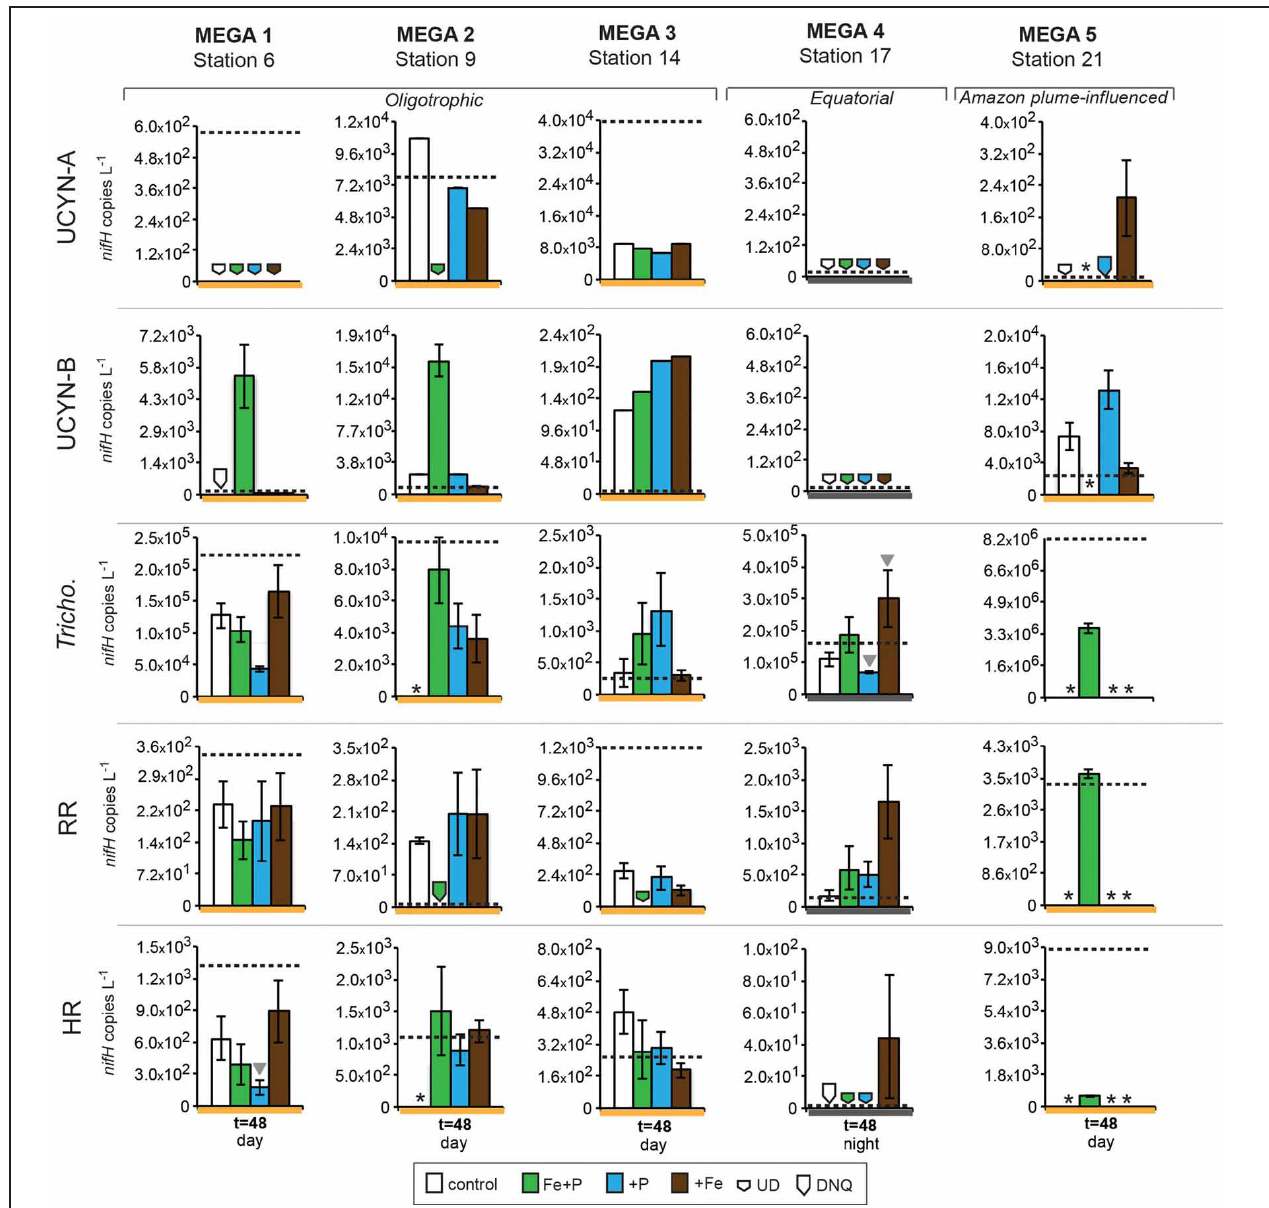
FIGURE 5 | Changes in nifH -based abundances in response to nutrient additions in the MEGA experiments between time zero and t = 48h samplings. Quantified nifH copies L − 1 in time zero samples in each experiment for each phylotype is marked with a dotted line. UCYN-A and UCYN-B nifH copies L − 1 were quantified from 0.2 µ m filters; Tricho , RR, and